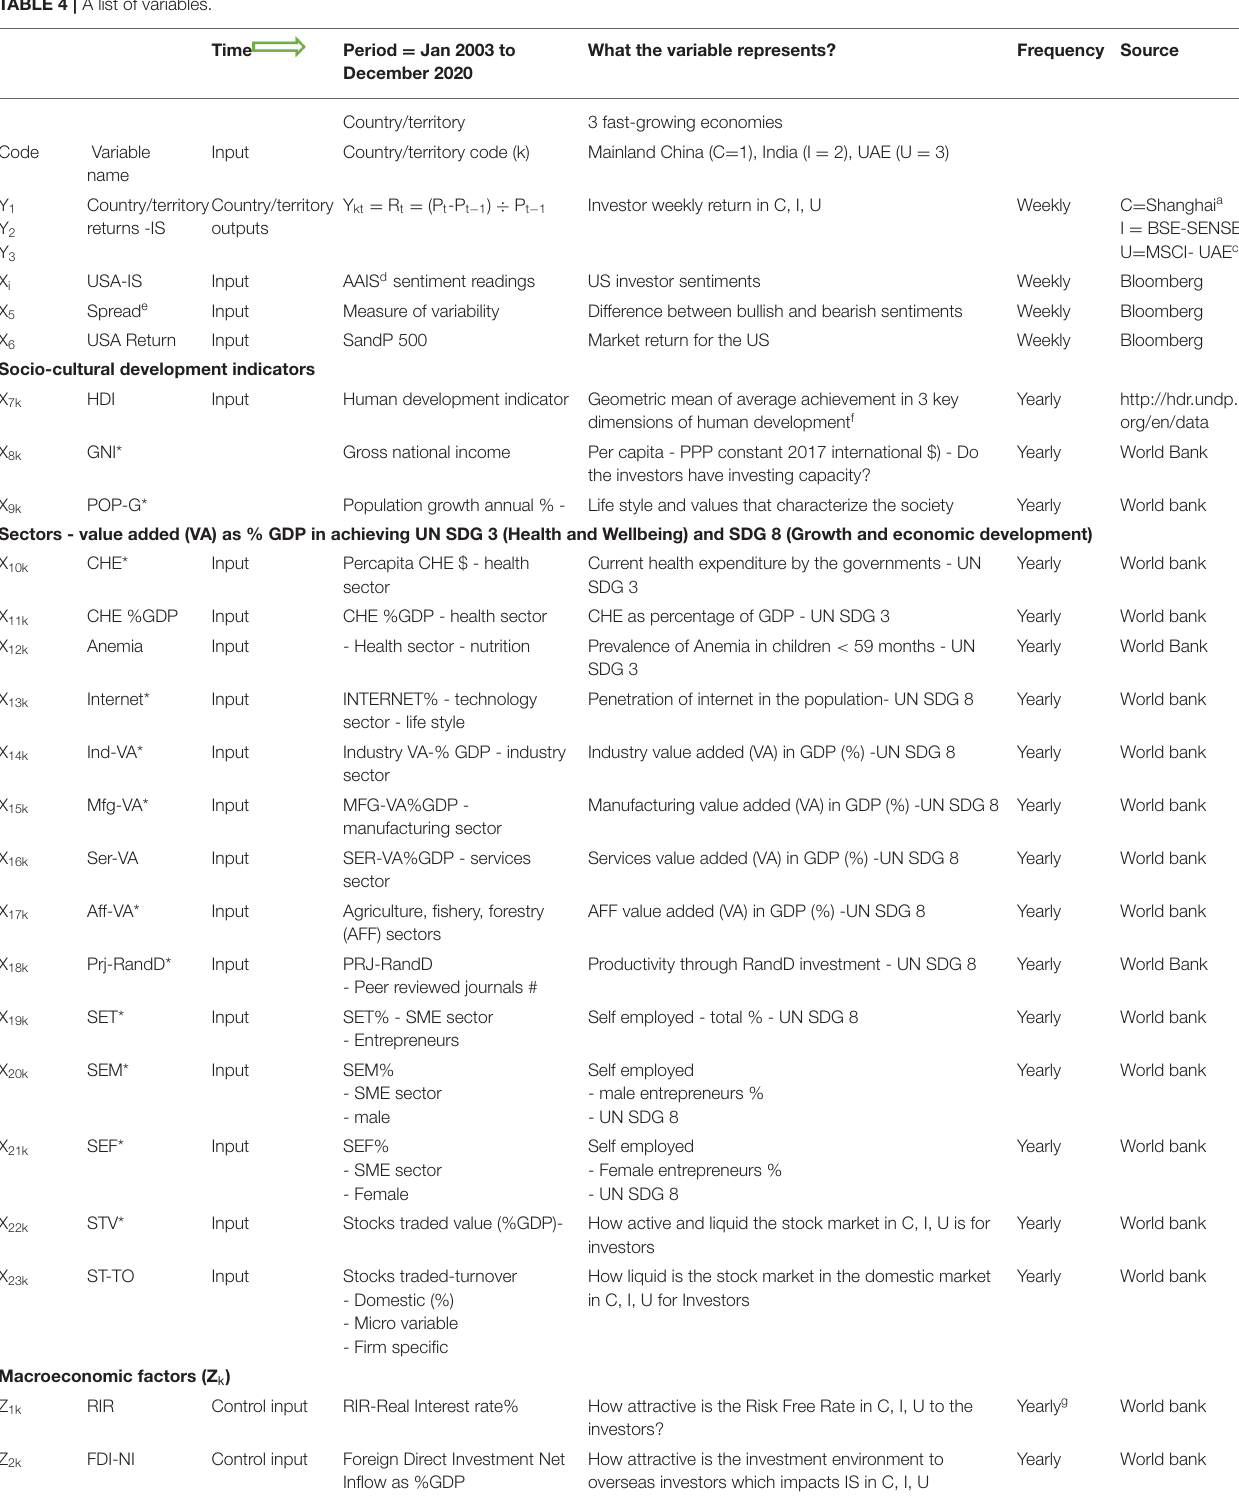
TABLE 4 | A list of